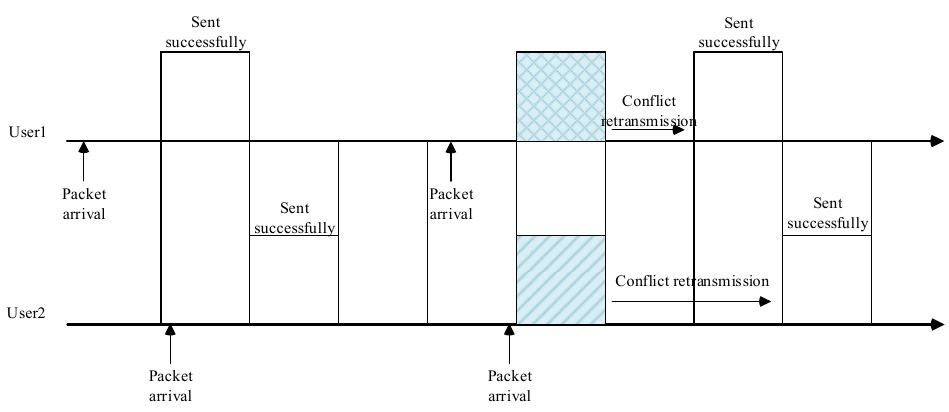
Figure 4. The working principle of slotted ALOHA.